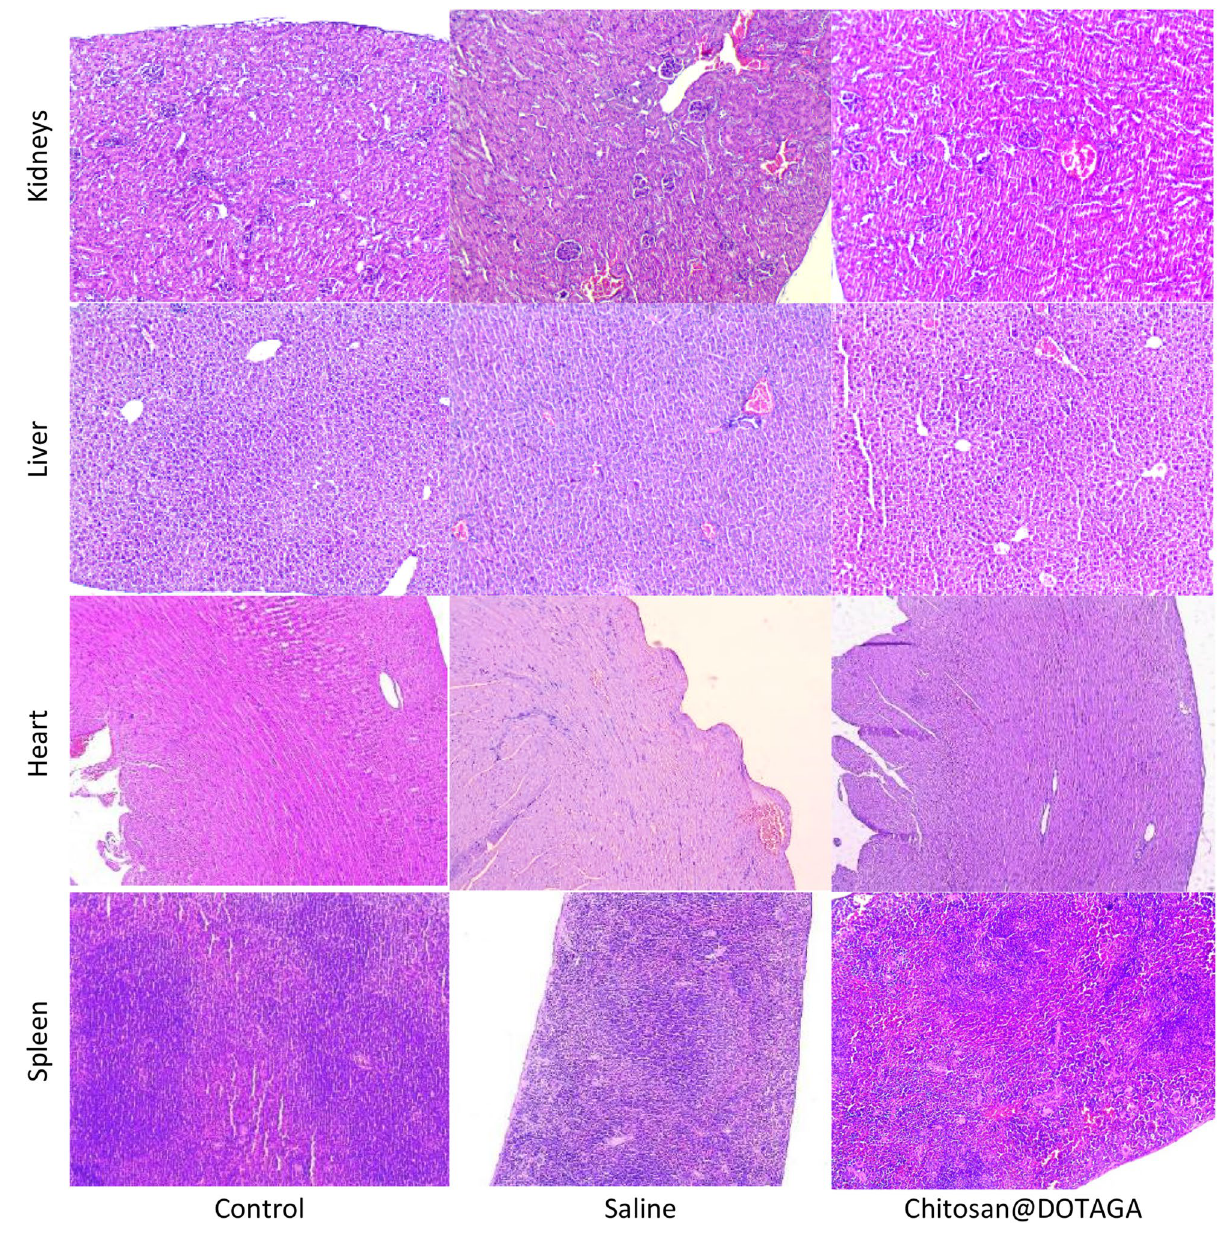
Figure 5. Histopathology of mice organs after sacrifice. Microphotographs of the kidneys, liver, heart, and spleen of the three experimental groups: control, saline-treated, and Chitosan@DOTAGA-treated. Magnification × 100, H&E. Kidney: interstitial nephritis, capillary dilation, loss of brush border (Saline-treated group), blood vessel dilation (Saline- and Chitosan@DOTAGA-treated groups); liver: Kupffer cell accumulation, lympho-histiocyte accumulation, vessel congestion, blood sinusoids dilation (Saline- and Chitosan@DOTAGA- treated groups); heart: blood vessel and capillary dilation (Saline- and Chitosan@DOTAGA-treated groups); spleen: marginal zone hyperplasia (Saline- and Chitosan@DOTAGA-treated groups), increased red pulp cellularity (Chitosan@DOTAGA-treated